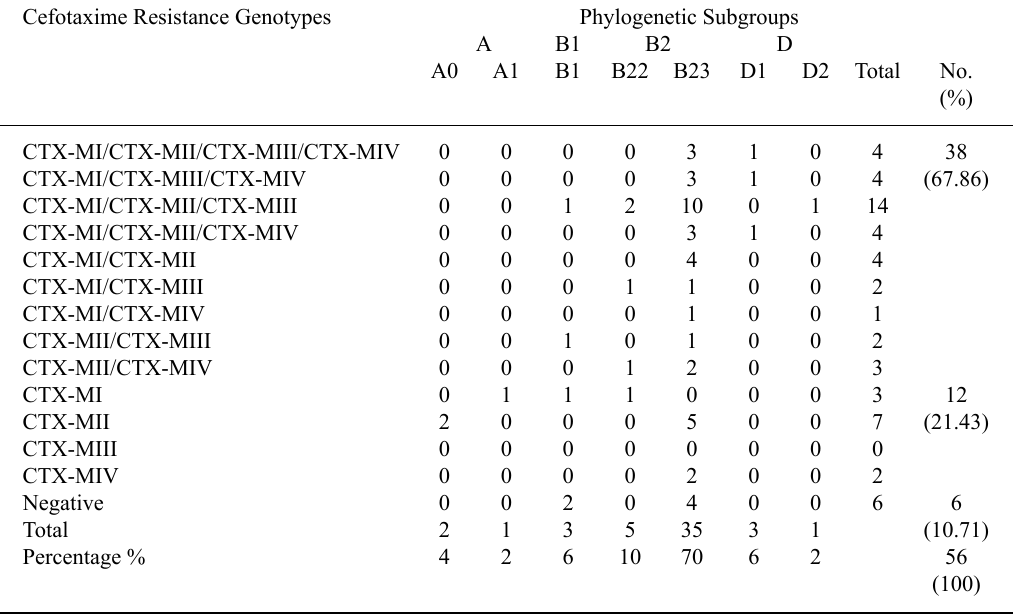
Table 3. Distribution of cefotaxime resistance genotypes among UPEC Cefotaxime Resistance Genotypes Phylogenetic